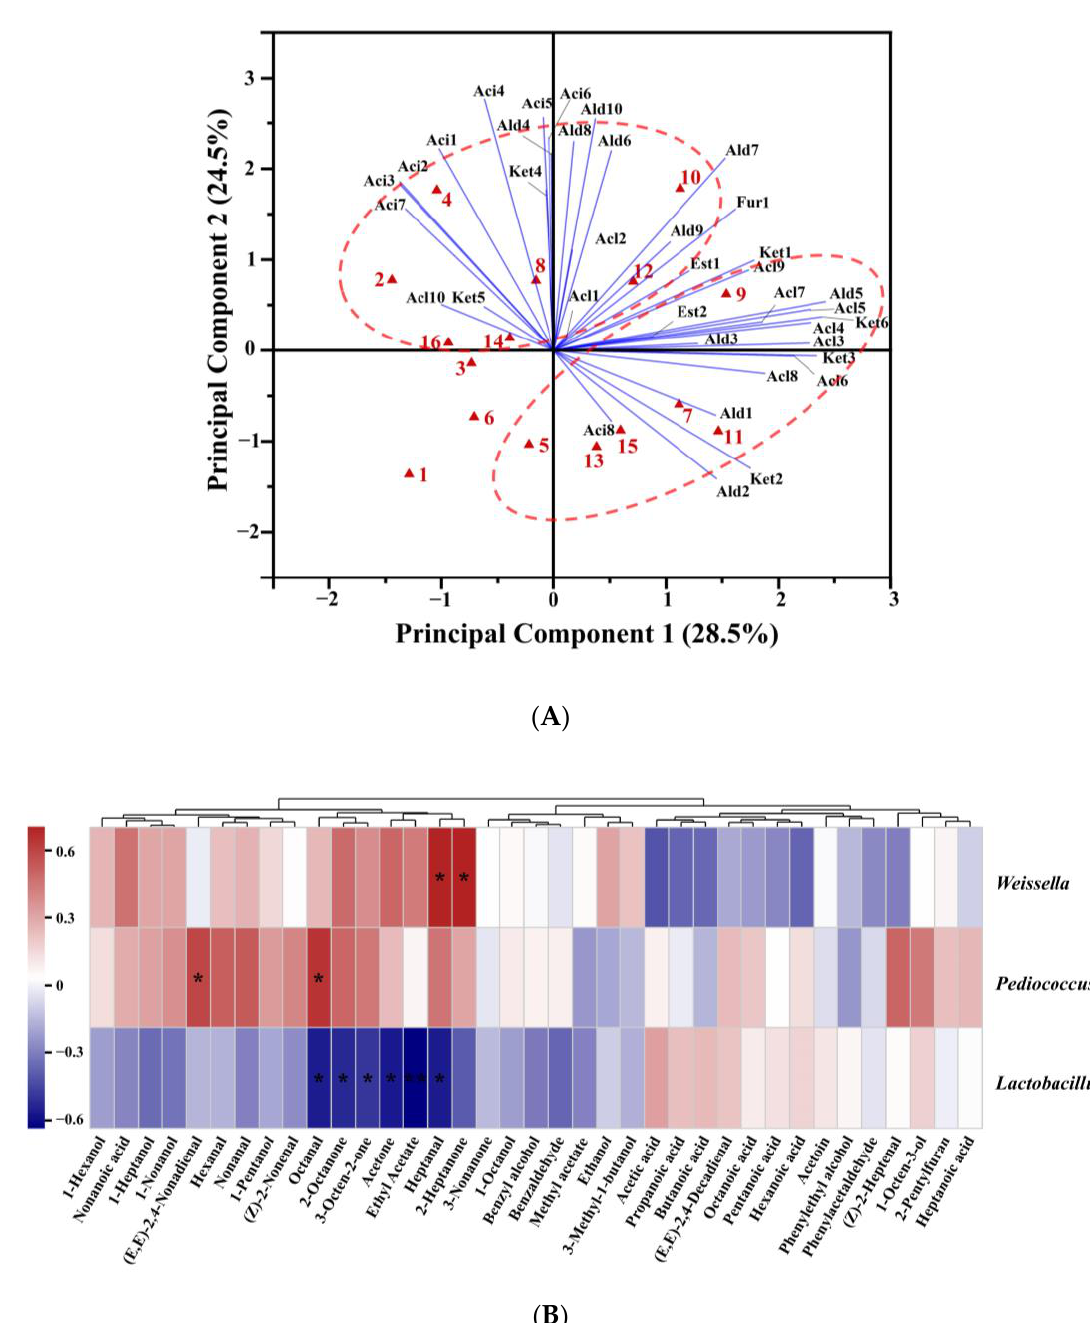
Figure 5. ( A ) Biplot drawn based on the first two principal components extracted by principal component analysis (PCA) of volatile compounds in alkali-free Chinese steamed breads (CSBs) and alkali-added CSBs. The names of the CSB samples and compounds in the biplot refer to Table S3. The numbers 1–16 represent alkali-free CSBs and alkali-added CSBs fermented by CTSs from eight regions of China in the sequence WW-AB, WW-FB, WN-AB, WN-FB, YC-AB, YC-FB, LY-AB, LY-FB, LK-AB, LK-FB, HZ-AB, HZ-FB, BZ-AB, BZ-FB, WH-AB, and WH-FB. Alc, Ald, Aci, Est, Ket, and Fur represent alcohols, aldehydes, acids, esters, ketones, and furan, respectively. ( B ) Comparison of volatile compounds in Weissella -, Lactobacillus -, and Pediococcus -associated CSBs. A heatmap was constructed using the relative abundance of bacteria in fermented doughs at the genus level. Spearman correlation with hierarchical clustering among the volatile compounds was applied. * p < 0.05; ** p < 0.01.